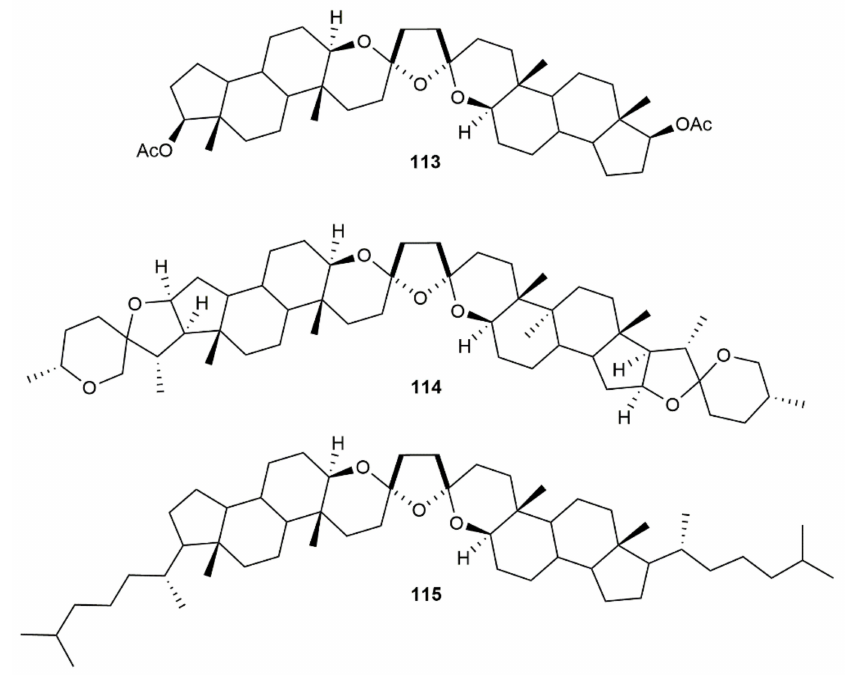
Figure 15. Structure of the steroid-derived bis-spiroketals 113 – 115